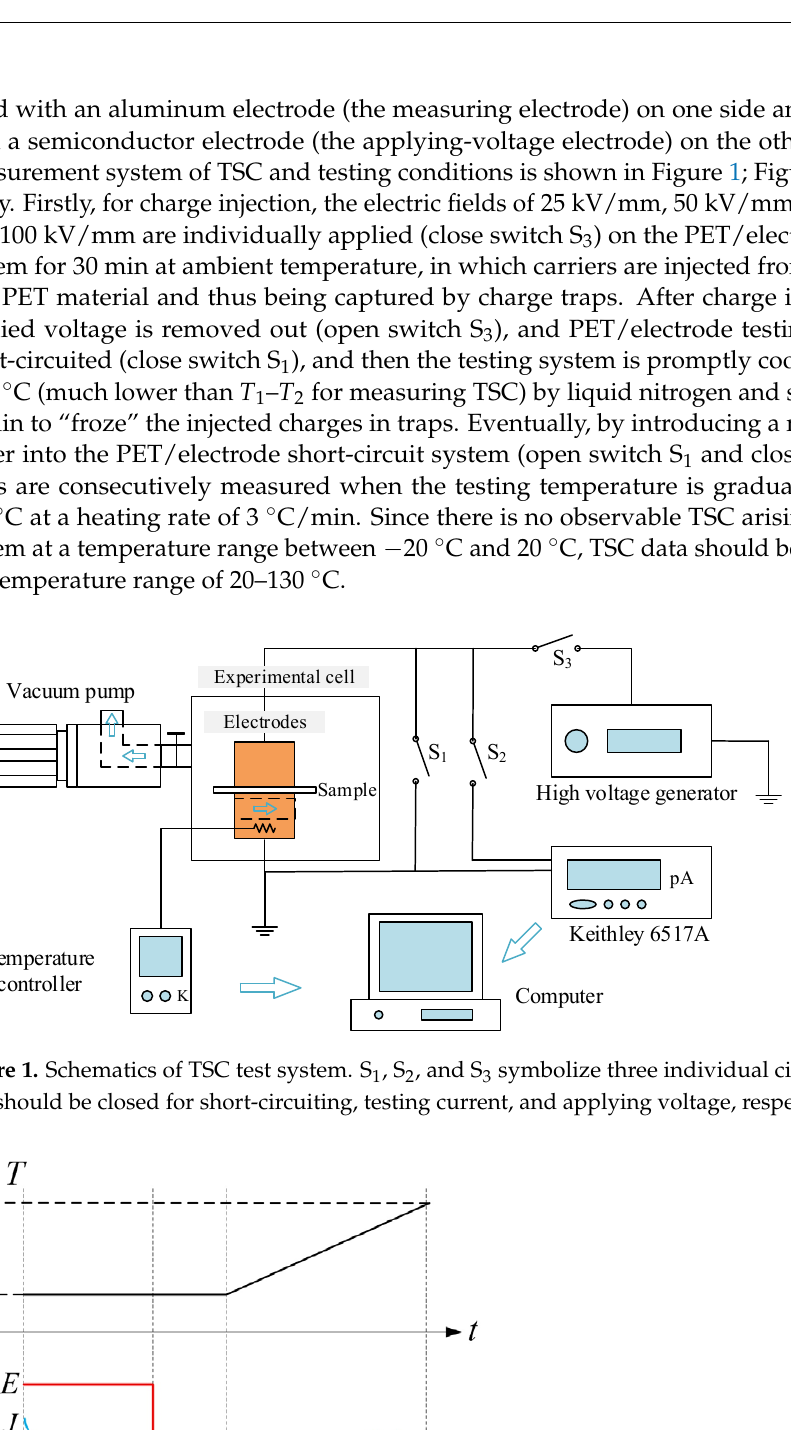
Figure 2. Temperature and electric field strength of PET ‐ electrode system varying with time in TSC test. E denotes electric field strength for charge injection; J represents electric current; T 1 and T 2 specify the lowest and highest temperatures for measuring TSC, respectively; t 0 and t 1 mark the beginning and end moments of charge injection, respectively; t 2 and t 3 represent the moments when TSC measurement begins and ends, respectively.